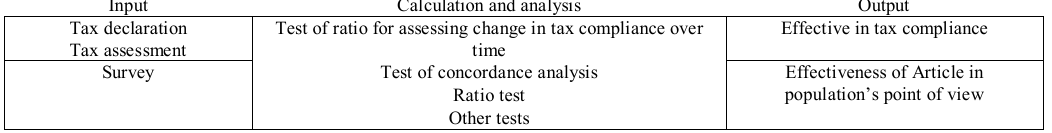
Fig. 1 . Conceptual model of the study